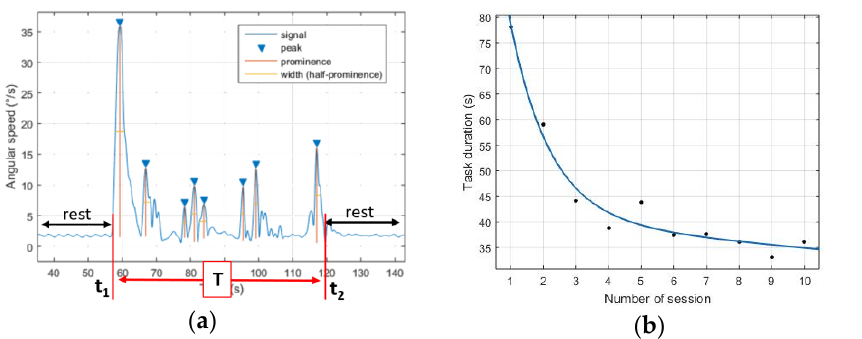
Figure 1. ( a ) Time extraction using a gyroscope signal and sensor 1 (task Grasping ). ( b ) Exponential approximation of the task duration decrease (task Coordination , LapSim data, 9